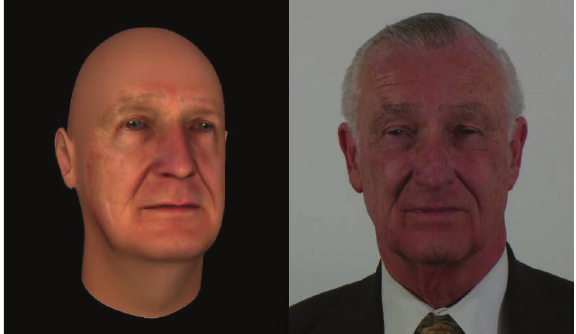
Figure 3. Comparison of the LifeLike Avatar to its Human Counterpart.